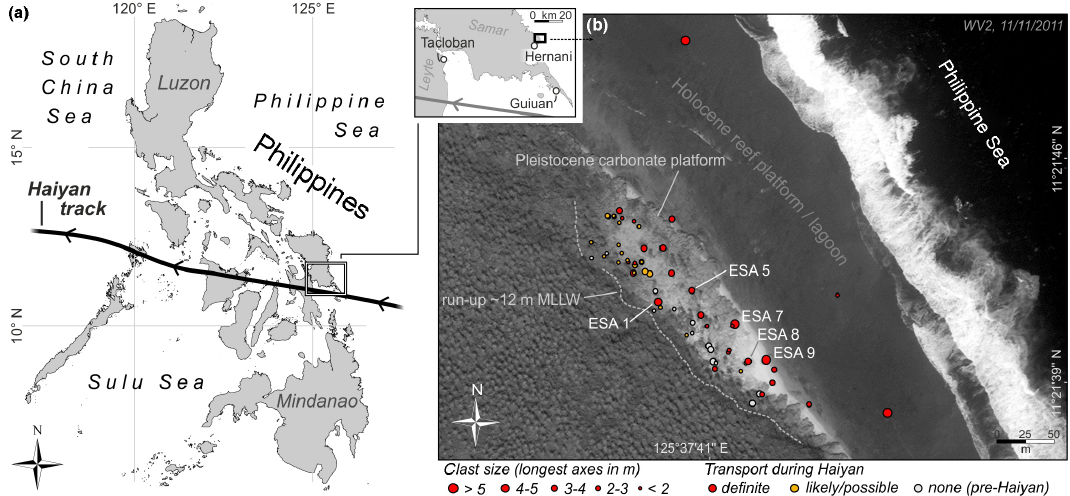
Figure 1. Study area and boulder field at site ESA. (a) Location of study area and Haiyan’s track. (b) Setting of the boulder field at site ESA (59 clasts documented). The post-Haiyan image illustrates the extent of destroyed vegetation and deposited sand (light grey, on top of the Pleistocene carbonate platform) (WV2, 11 November 2013). Large clasts were moved on top of the Holocene reef as well as on top of the Pleistocene platform. A number of boulders ( ∼ 30 clasts) were definitely transported, and dislocation of several further boulders is very likely. Further clasts must have been transported during an older palaeo-wave